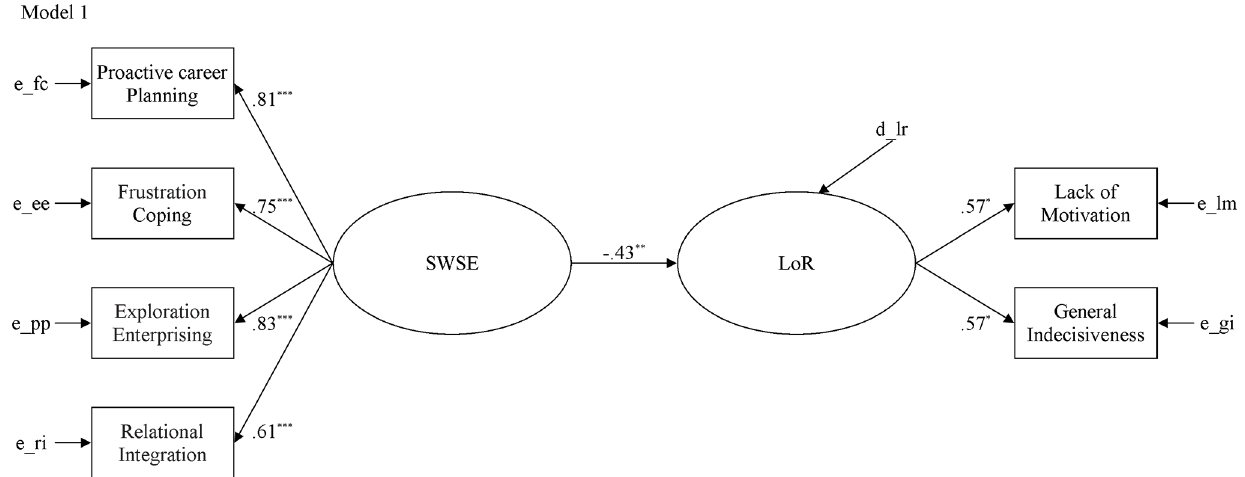
Figure 1. Estimated structural equation model for the relationship between search for work self-efficacy and lack of